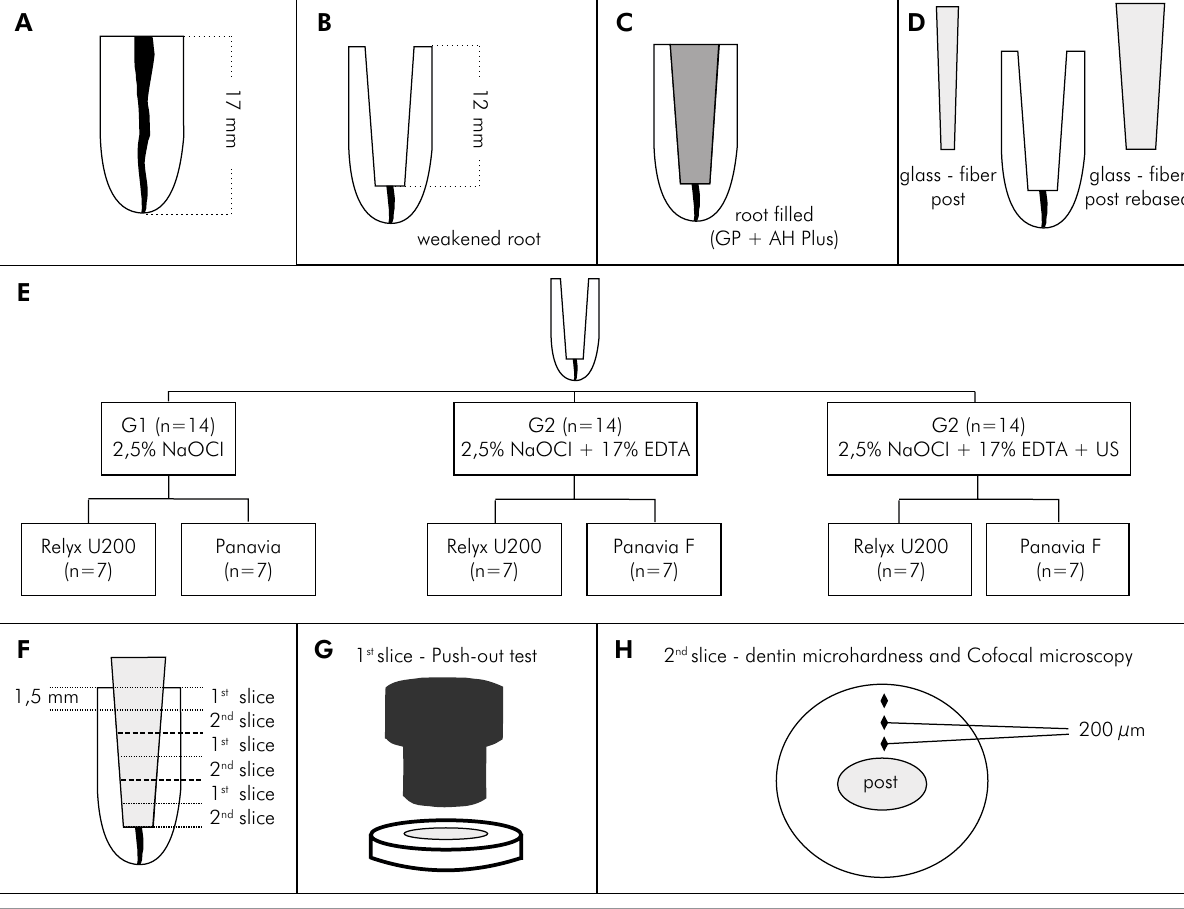
Figure 2. Schematic picture illustrating the study